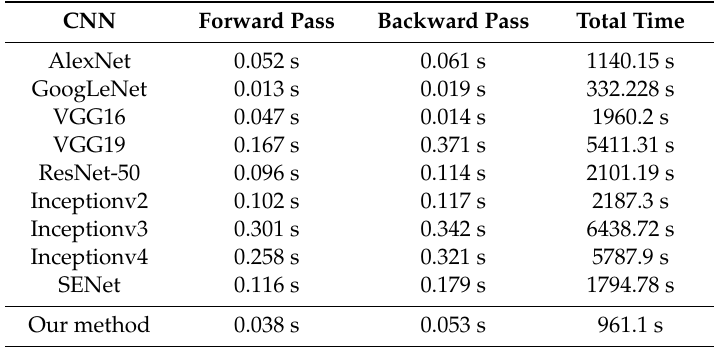
Table 4. Comparison of training time for di ff erent CNN